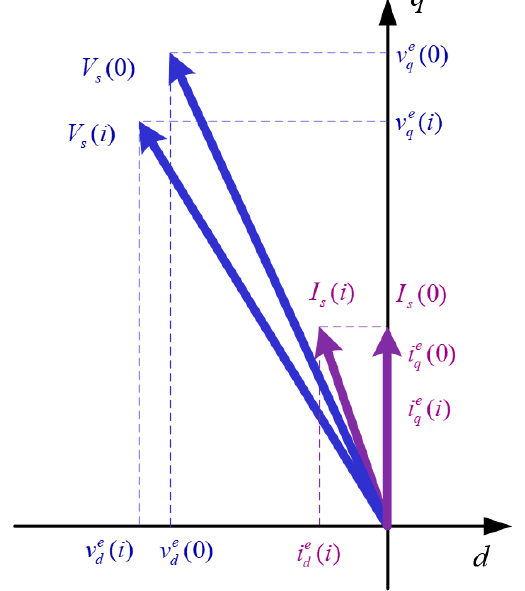
Figure 5. Voltage and current vectors for temperature estimation.